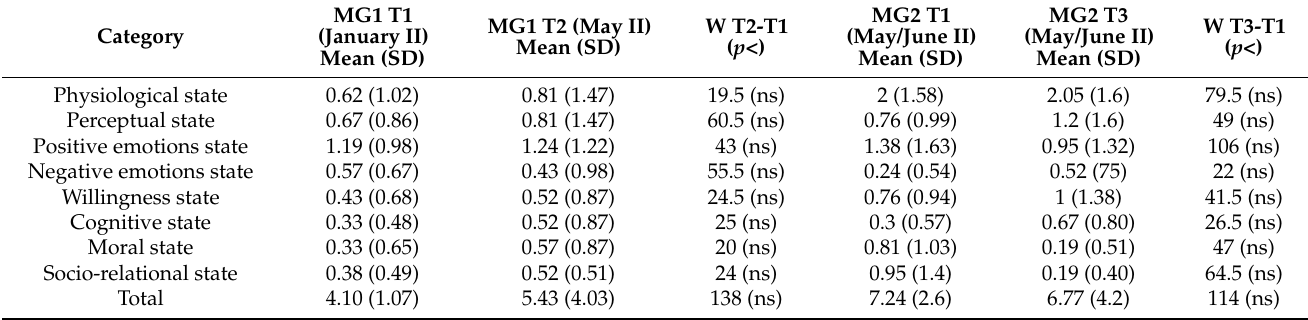
Table 4. Frequency of the psychological lexicon used by MG1 MG2 in the respective times of detection and comparison for paired groups in the Wilcoxon